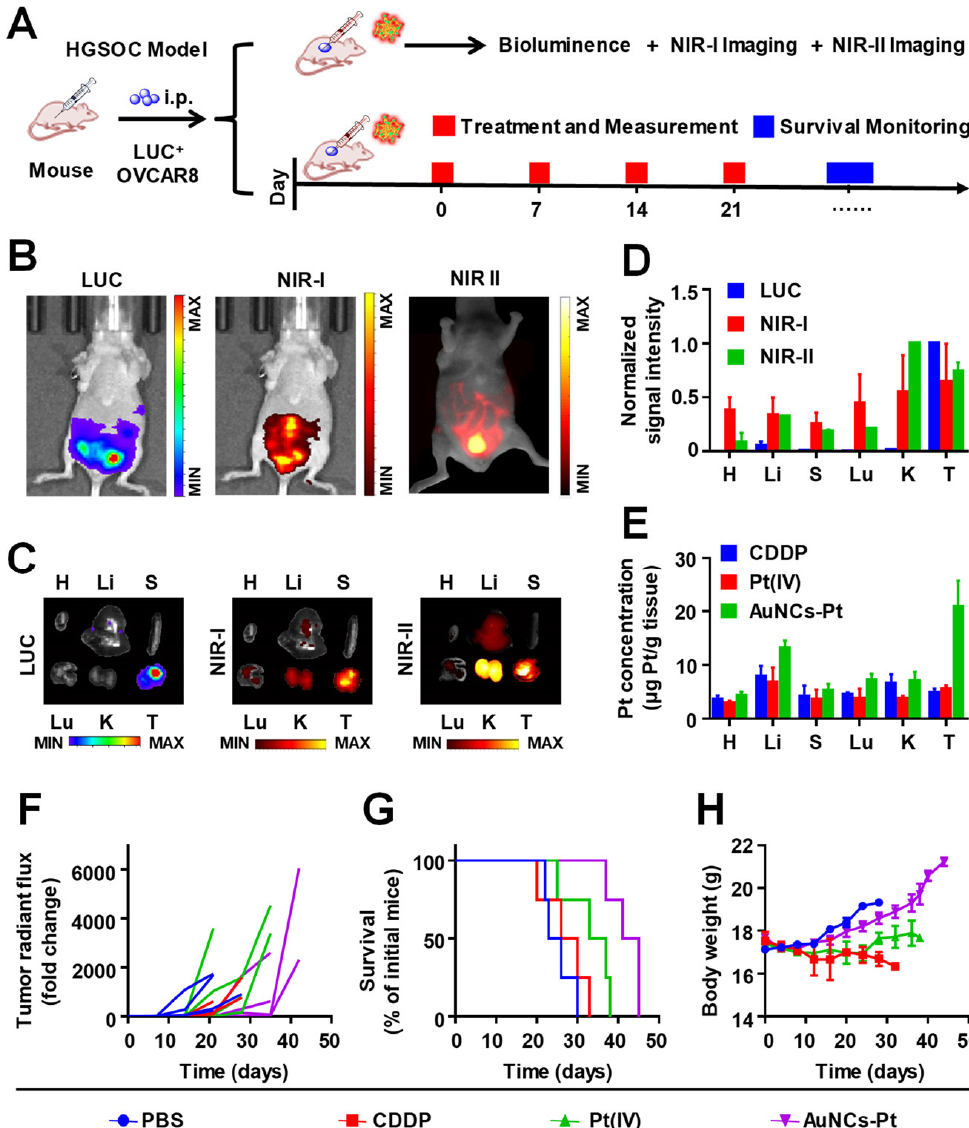
Figure 3. In vivo imaging and therapeutic efficiency of Au 25 NCs-Pt on an orthotopic model. ( A ) Scheme of establishing an orthotopic model. ( B ) Representative in vivo images at 12 h after AuNCs-Pt administration. ( C ) Ex vivo images and ( D ) the intensities of ex vivo signal in heart (H), liver (Li), spleen (S), lung (Lu), kidney (K), and tumor (T) at 12 h. ( E ) Pt distribution after 12 h injection. ( F ) Time duration of the tumor burden. ( G ) Survival of the HGSOC-bearing mice. ( H ) Body weights of mice during the treatment. Reprinted with permission from [96]. Copyright 2020 American Chemical Society.